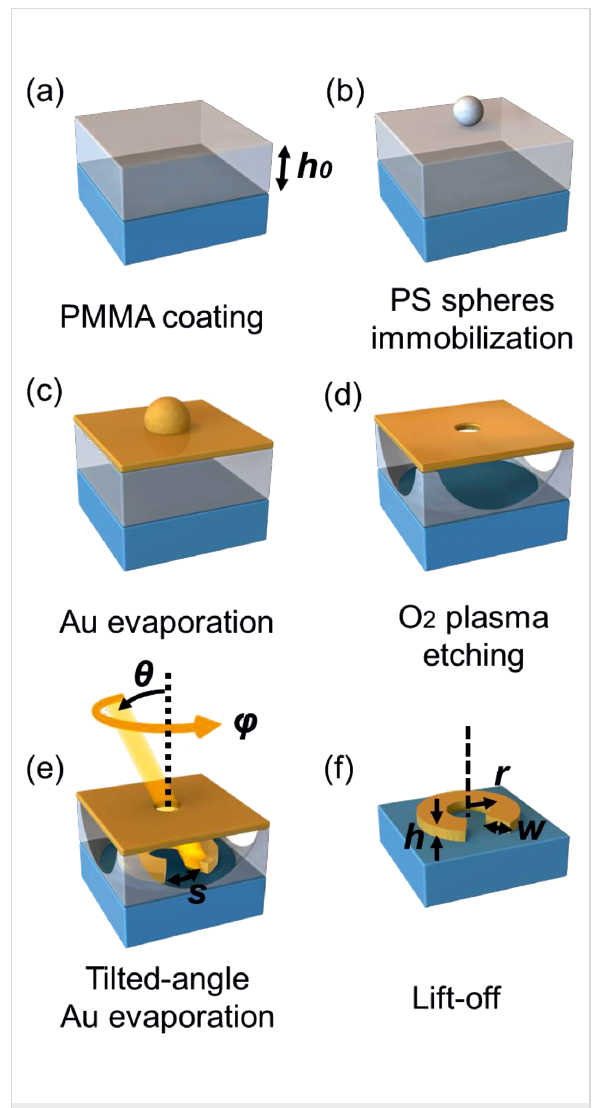
Figure 1: Fabrication scheme. (a) Deposition of sacrificial PMMA layer. (b) Deposition of polystyrene spheres in an arbitrarily distributed arrangement. (c) Evaporation of oxygen plasma resistant Au-mask. (d) Removing polystyrene spheres with ultrasonic bath and subse- quent isotropic dry etching leads to extended holes in PMMA layer. (e) Evaporation of the structures by tilted angle evaporation (polar rota- tion angle φ , azimuthal tilt angle θ ). (f) Lift-off of the sacrificial PMMA layer. Reproduced with permission from [23]. Copyright 2012